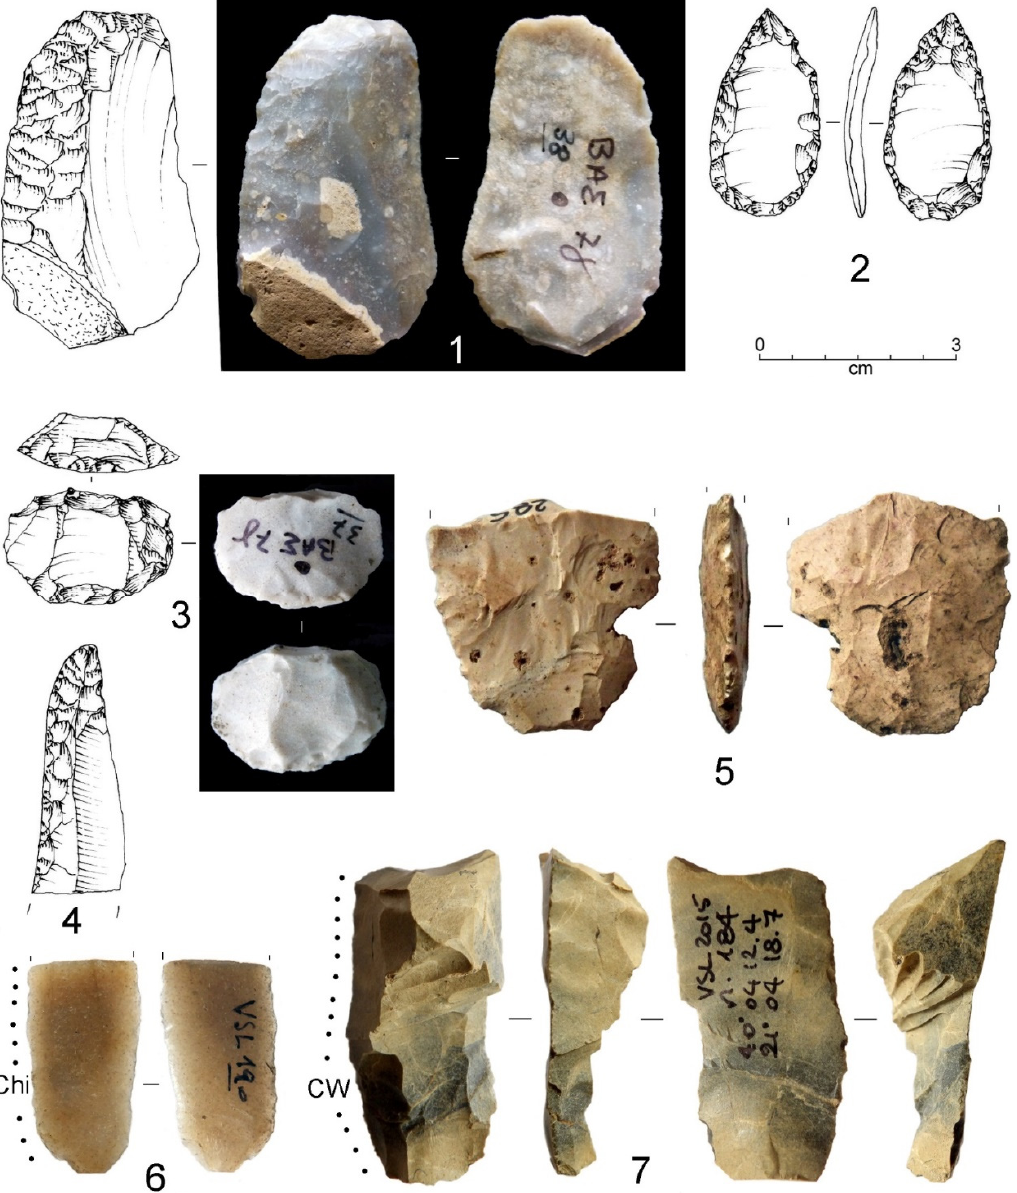
Figure 16. Mount Vasilitsa: Holocene knapped stone artefacts made from non-local chert: Site VSL 1: Flat-retouched side scraper (n. 1), bifacial arrowhead (n. 2), short end scraper (n. 3), flat-retouched bladelet (n. 4), proximal fragment of flat-retouched, bifacial dagger (VSL-285, n. 5) and artefacts with utilisation traces (VSL-190, cut hide (Chi), n. 6; and VSL-184, cut wood (CW), n. 7) (photographs by E. Starnini).